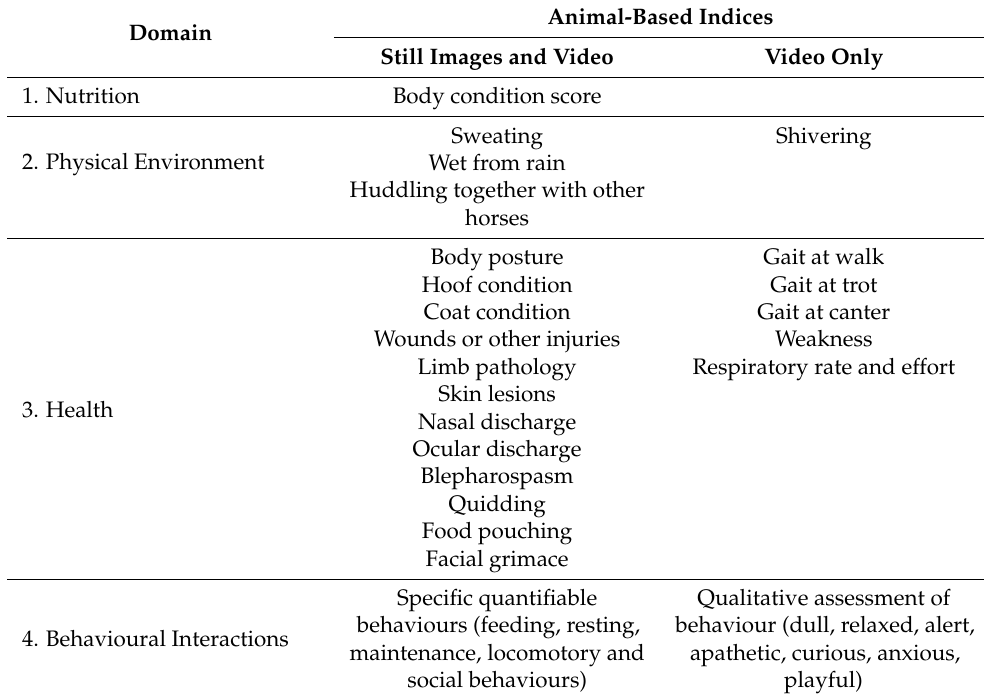
Table 2. List of selected welfare indicators in each